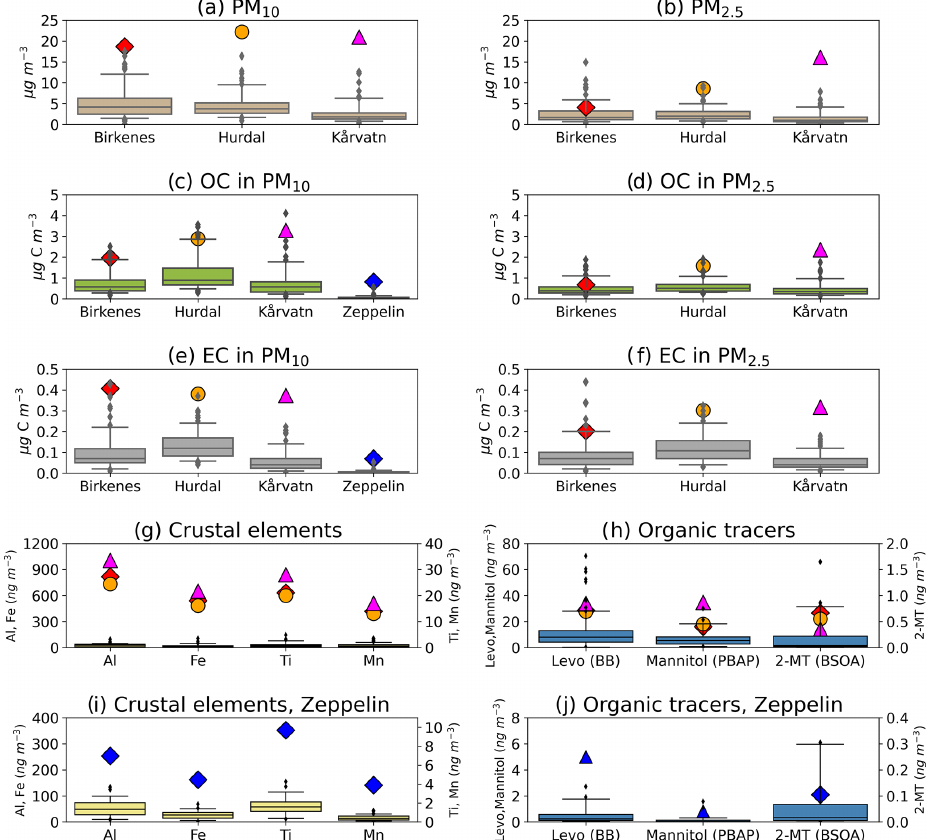
Figure 4. Panels show concentrations observed in the October 2020 episode (red diamonds: Birkenes; orange circles: Hurdal; purple trian- gles: Kårvatn; blue diamonds: Zeppelin) along with box plots (5th, 25th, 50th, 75th, and 95th percentiles and outliers) at the rural background sites Birkenes, Hurdal, and Kårvatn as well as the remote site Zeppelin of weekly data in the period September–November for (a) PM 10 mass concentration (2010–2019); (b) PM 2 . 5 mass concentration (2010–2019); (c) organic carbon (OC) in PM 10 (2010–2019 for Birkenes, 2011– 2019 for Hurdal and Kårvatn, and 2017–2019 for Zeppelin); (d) OC in PM 2 . 5 (similar to panel c but for Zeppelin with no measurements); (e) elemental carbon (EC) in PM 10 (similar to panel c ); (f) EC in PM 2 . 5 (similar to panel d ); (g) crustal elements in PM 10 (2014–2019); (h) levoglucosan (2010–2019), mannitol, and 2-methylerythritol in PM 10 (2016–2018); (i) crustal elements in PM 10 at Zeppelin (2018– 2019); and (j) levoglucosan, mannitol, and 2-methylerythritol in PM 10 at Zeppelin (2017–2019). In panels (g) and (h) the box plots are for Birkenes